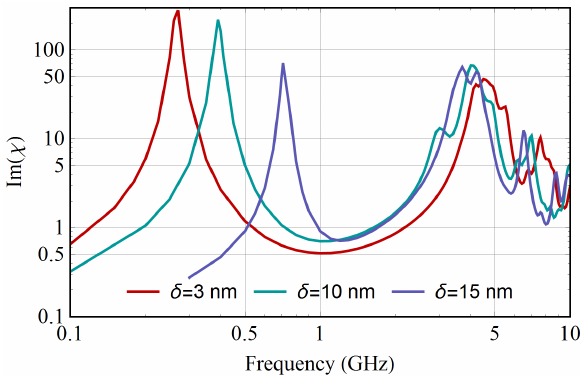
Figure 6. Ordered arrays of nanoplatelets with a centered macro- vortex state and a vortex core. E ff ect of the interplatelet spacing on the Im( χ xx ) spectrum. The array size is fixed at 5 × 5.